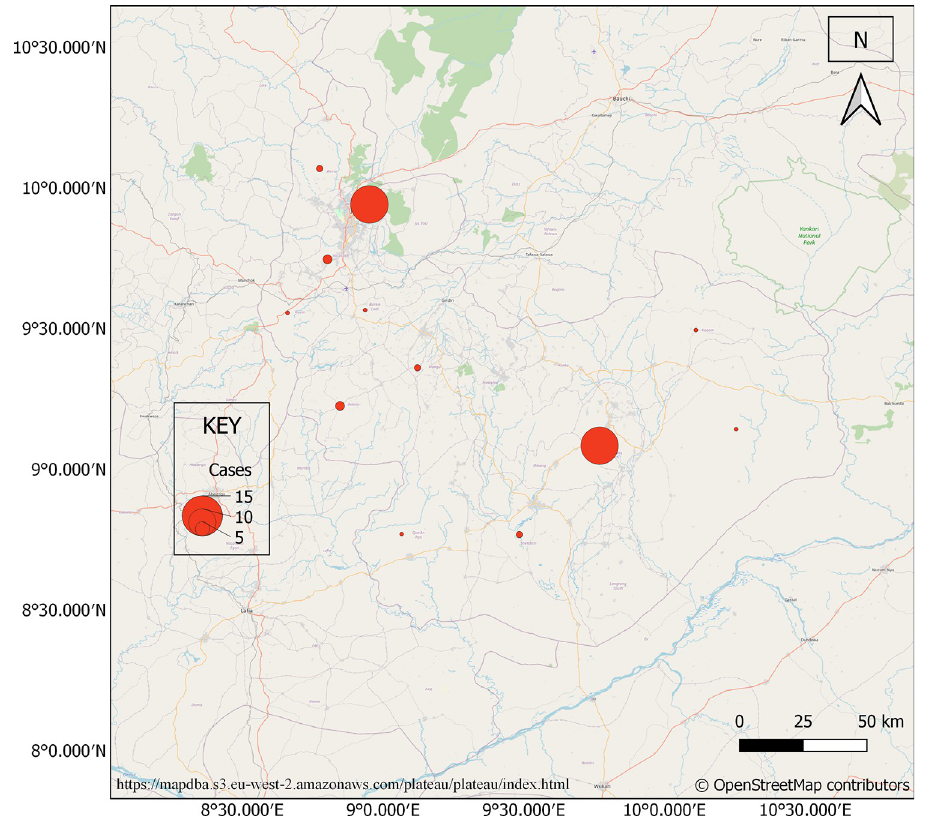
Fig 2. Distribution of confirmed Lassa fever cases across different local government areas of Plateau State 2016– 2018. Base map from OpenStreetMap and OpenStreetMap Foundation [https://mapdba.s3.eu-west-2.amazonaws. com/plateau/plateau/index.html].